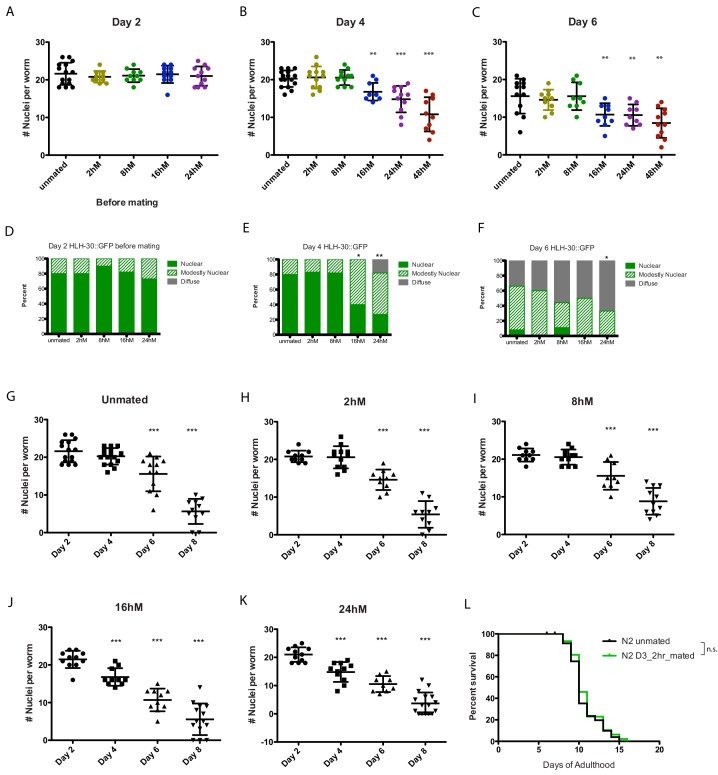
Quantitation of HLH-30::GFP in worms at different ages and after mating for various lengths of time.(A–K) HLH-30::GFP becomes more diffuse with age, even if the hermaphrodites have not been mated; however, mating accelerates this process. All worms were mated on Day 3 of adulthood. (B, C; E–K) 2 hr and 8 hr mating seem to have no impact on HLH-30::GFP localization (same as unmated control). However, starting from 16 hr mating, HLH-30::GFP become less nuclearly localized. (L) Control of Figure 4A,N2 hermaphrodites do not live shorter after 2 hr mating on day 3 of adulthood. N2 unmated: 13.4 ± 0.5 days; N2 mated: 12.7 ± 0.4 days, p=0.2263.